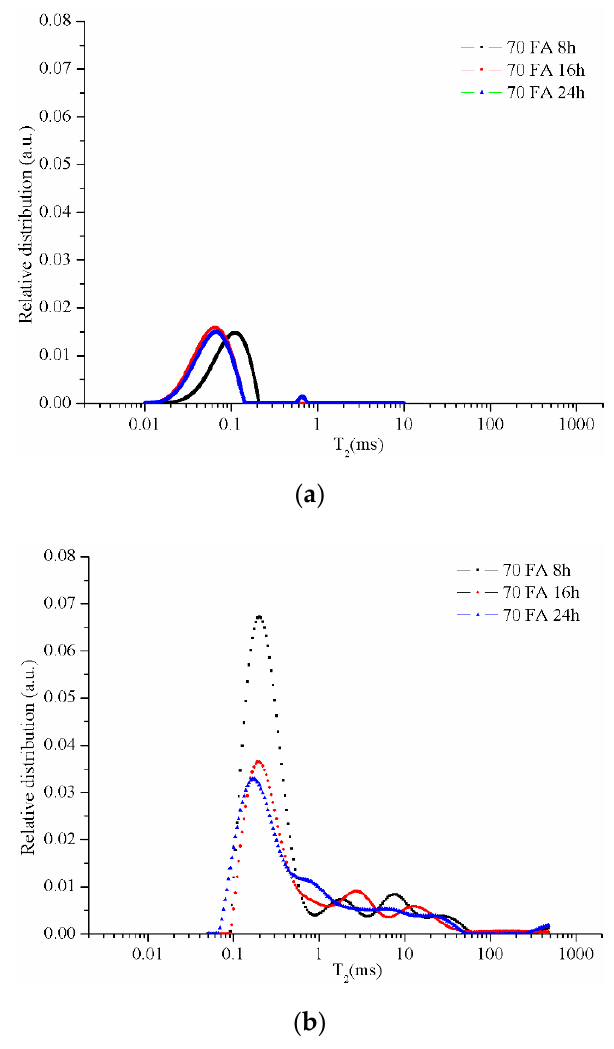
Figure 7. Relative pore size distribution in sample 70 FA dried for 8, 16, or 24 h: ( a ) after 48 days of activation and ( b ) after 7 days of immersion in